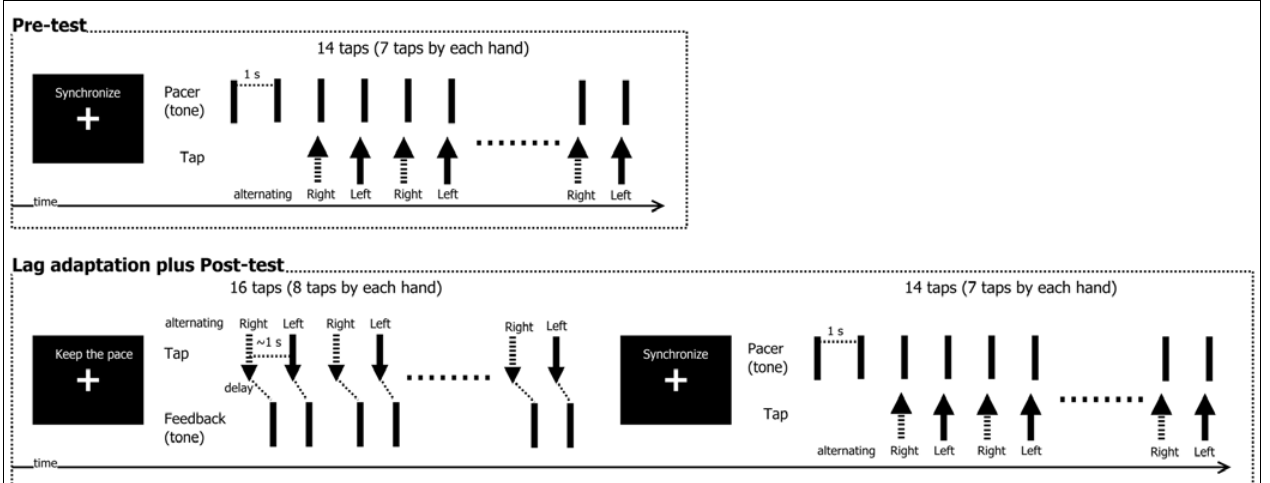
while trying to maintain a constant tempo. Each tap was followed by a feedback tone with either 50 or 150 ms delay. Following exposure to these delays, participants then again tried to synchronize their left-right finger taps with a pacer tone (as in the